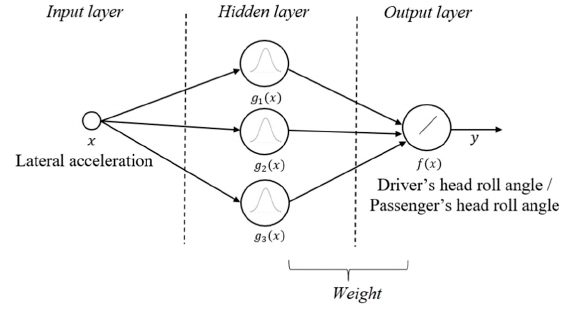
Figure 5. Pre-defined path.